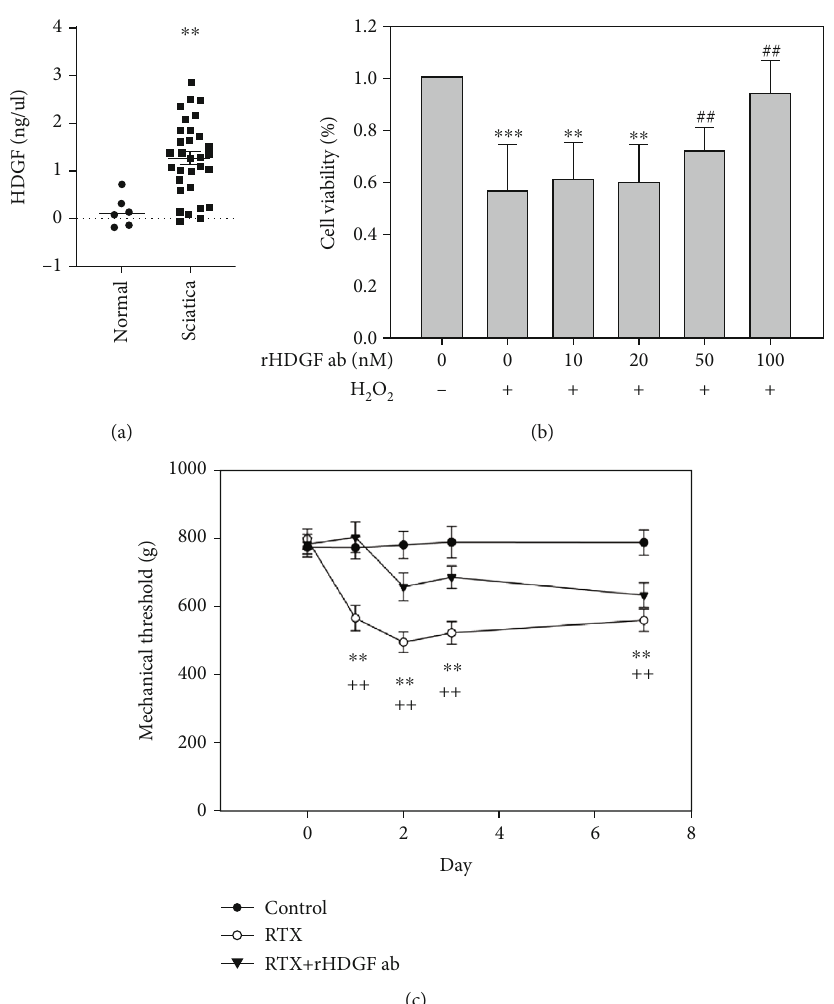
Figure 1: Serum HDGF is expressed higher in sciatica patients and rHDGF antibody increases pain threshold in RTX-treated rats. (a) Comparison of serum HDGF protein expression between sciatica patients and normal controls after ELISA analysis. The values detected from individuals were drawn as dots. The expression levels were shown as scattered plots; the middle line demonstrated the mean value. ∗∗ P < 0 : 01 compared with normal controls. (b) The PC-12 cells were incubated with di ff erent concentrations of rHDGF antibody (0, 10, 20, 50, and 100nM) and 500 μ M H O . Values are expressed as percentages of viable cells. ∗∗ P < 0 : 01 , ∗∗∗ P < 0 : 001 compared with 2 2 control group (without rHDGF antibody and H O ). ## P < 0 : 01 compared with the control group treated with 500 μ M H 2 2 expressed as the mean + SEM ( n = 6 ). (c) After the rats were divided into three groups, neuropathy was induced by